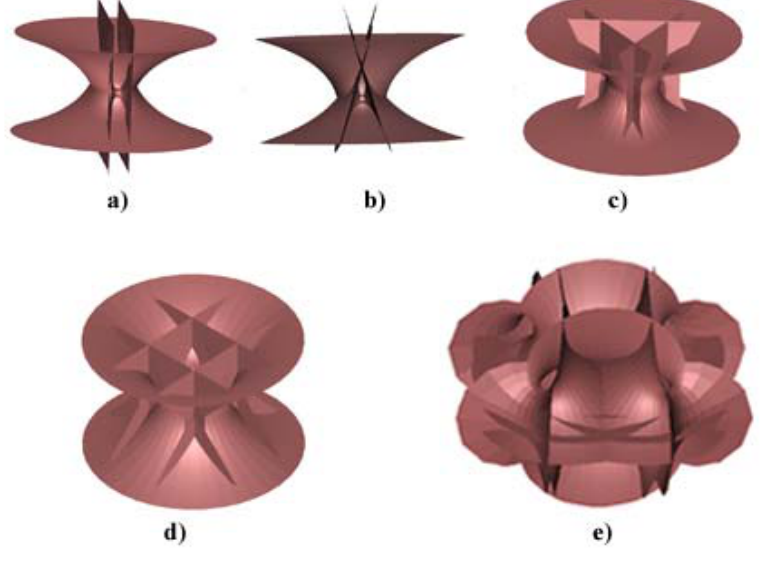
˜ X (n,m) associated to the catenoid by